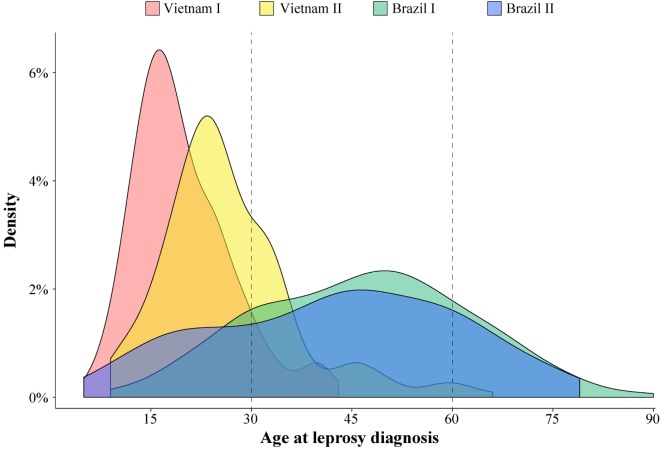
Age at leprosy diagnosis density in leprosy type-1 reaction (T1R)-affected patients. The age distribution of 996 T1R-affected leprosy cases from the 4 studied populations is plotted according to the density of cases.